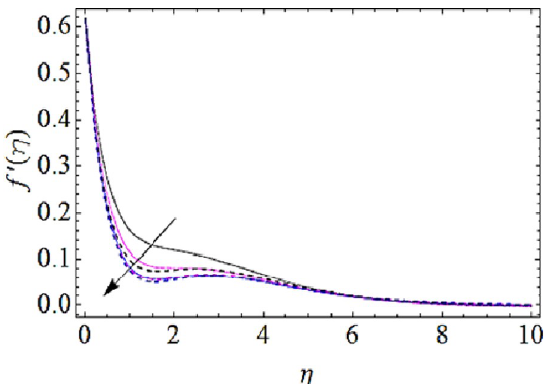
Fig 4. Velocity profiles for different values of Ag volume fraction.